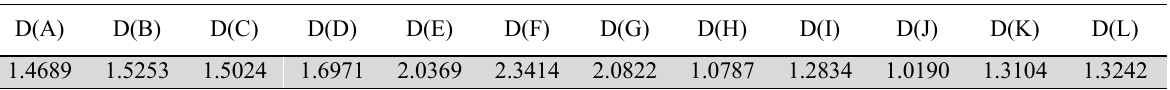
The results of the effects